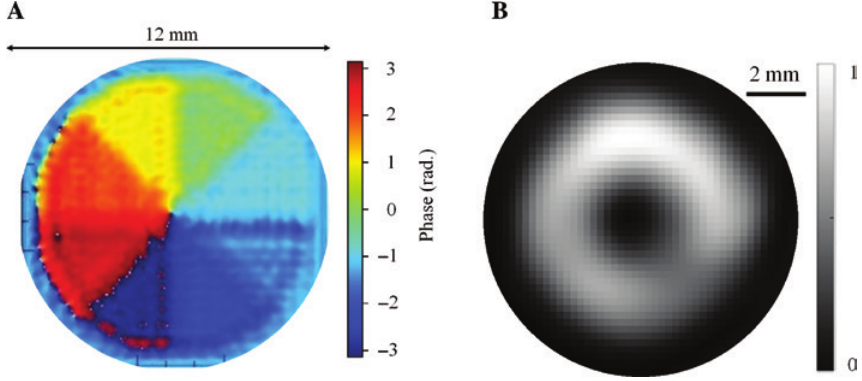
Figure 4: FDTD simulation of transmission phase and intensity of the SPP. (A) Azimuthal phase variation from 0 to 2 π and (B) electric field intensity | E | 2 distribution of the THz vortex beam generator. The simulation frequency is 0.78